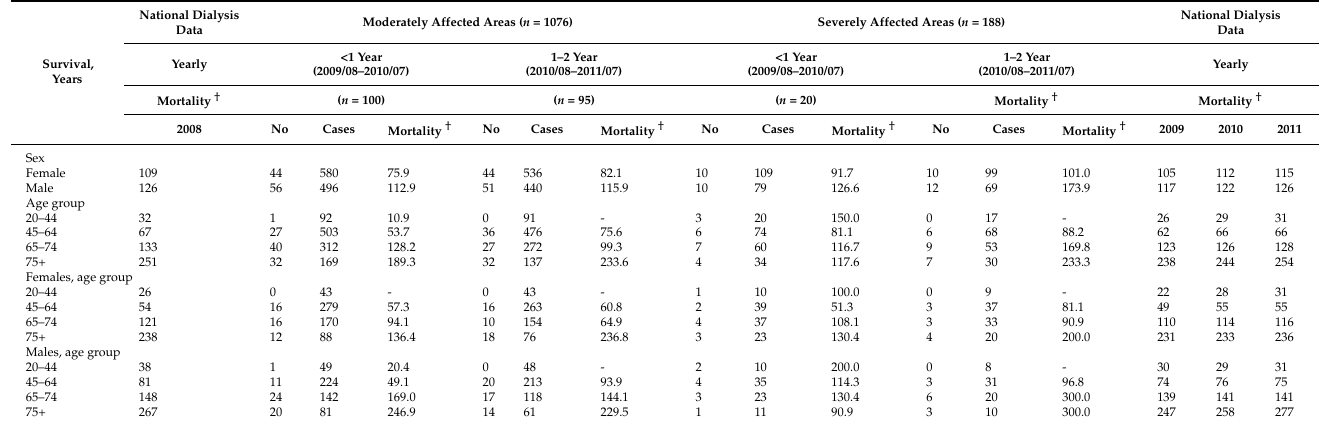
Table 3. Mortality in dialysis patients living in different places before and after Typhoon Morakot.